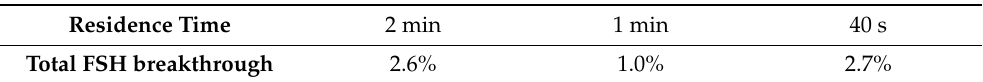
Table 1. Target protein loss at DBC 10% for Capto MMC resin at various residence times. Data for cycles